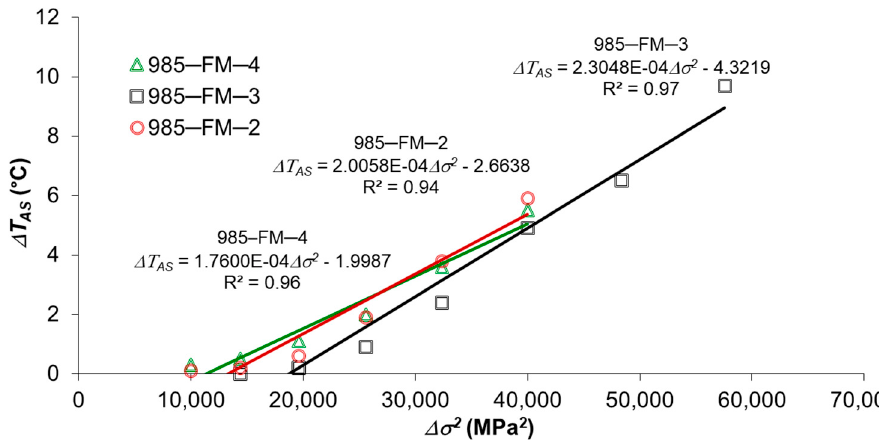
Figure 9. Δ T AS ─ Δ σ 2 curves for type-C-3 joints.